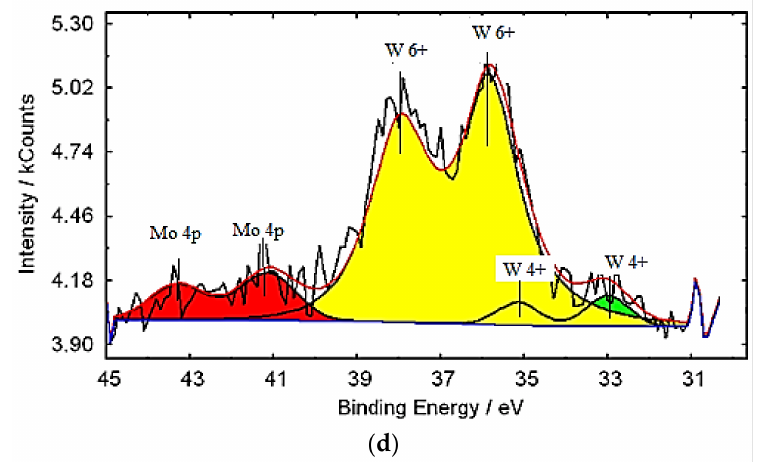
Figure 6. X-ray photoelectron spectroscopy (XPS) spectra of W ( a – d ) in molybdenum–tungsten oxide nanoclusters: (Mo)/(W) = 95/5 ( a ); (Mo)/(W) = 90/10 ( b ); (Mo)/(W) = 80/20 ( c ); and (Mo)/(W) = 50/50 ( d